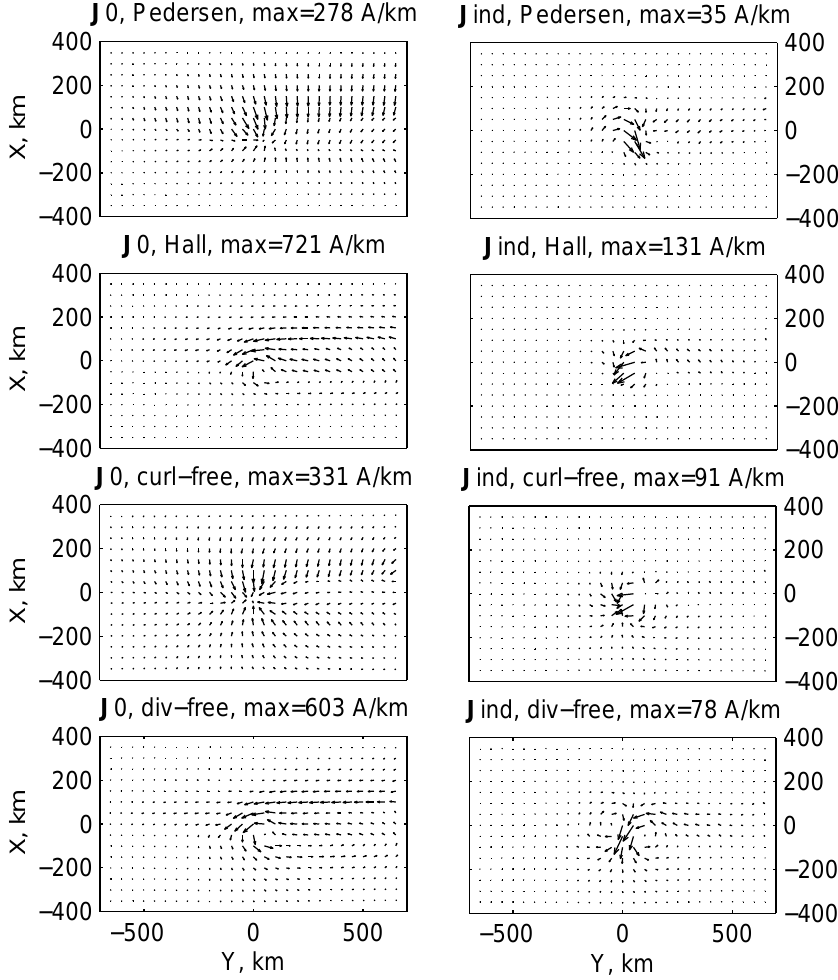
Fig. 6. The input current system (left side) and the induced current system (right side) of the WTS model decomposed into Pedersen, Hall, curl-free and divergense-free